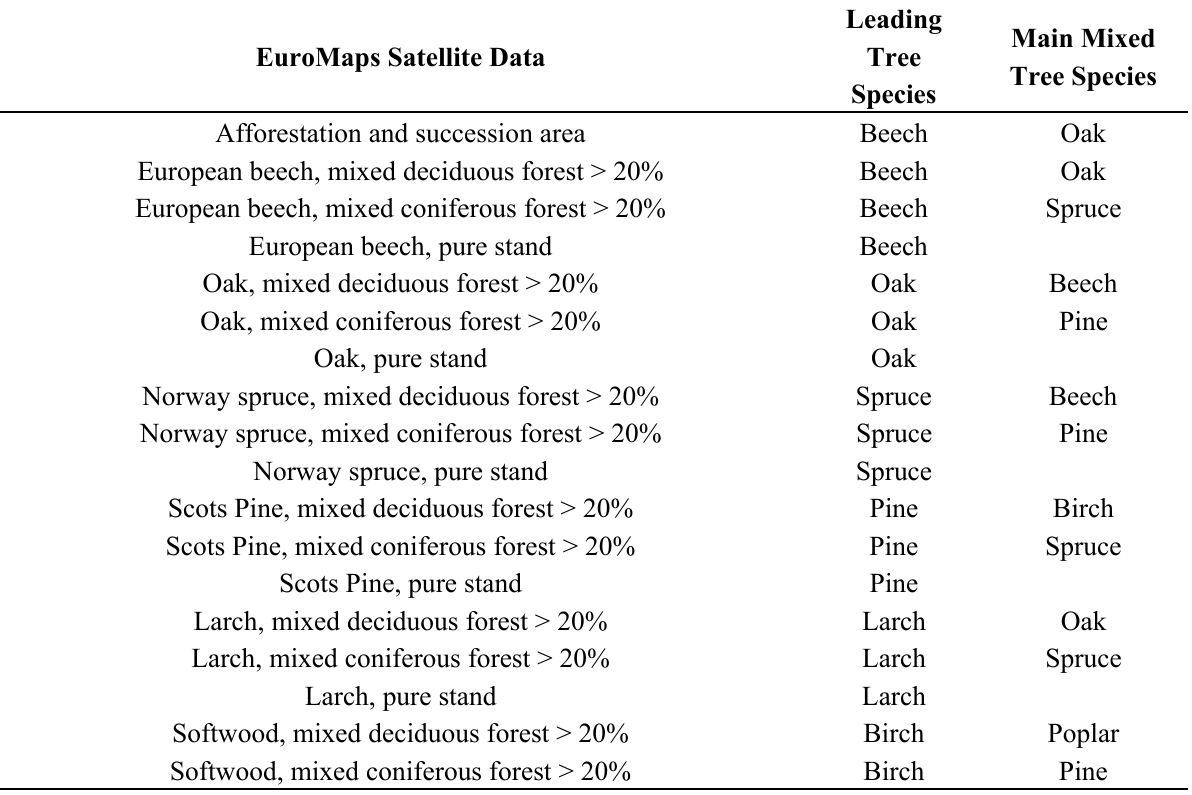
Table A1. Assignment of tree species to satellite data (EuroMaps, © EUROMAPS 2012), which were not classified as forest in the forest inventory